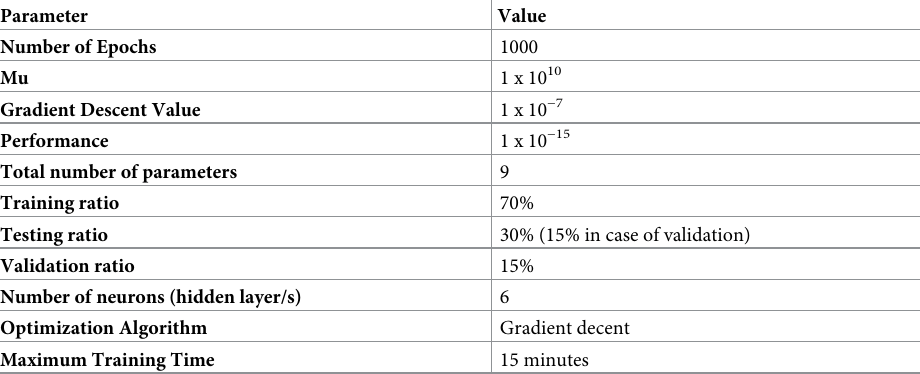
Table 5. Parameters for the neural network.